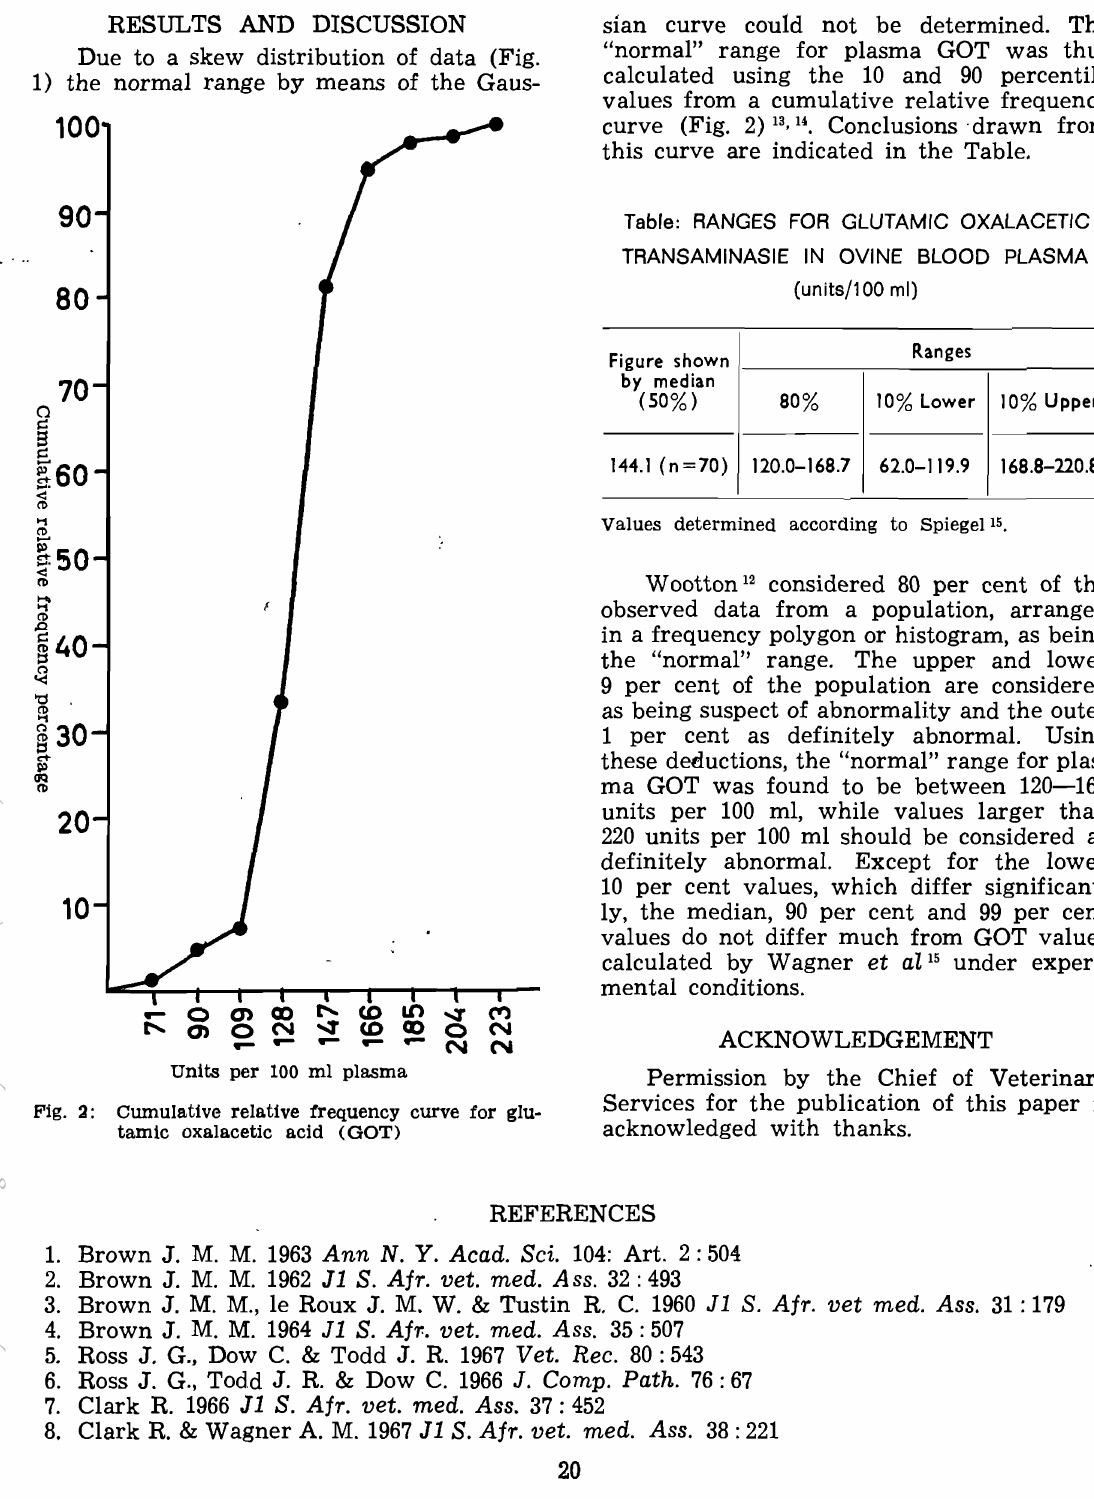
Fig. 2: Cumulative relative frequency curve for glu tamic oxalacetic acid (GOT)